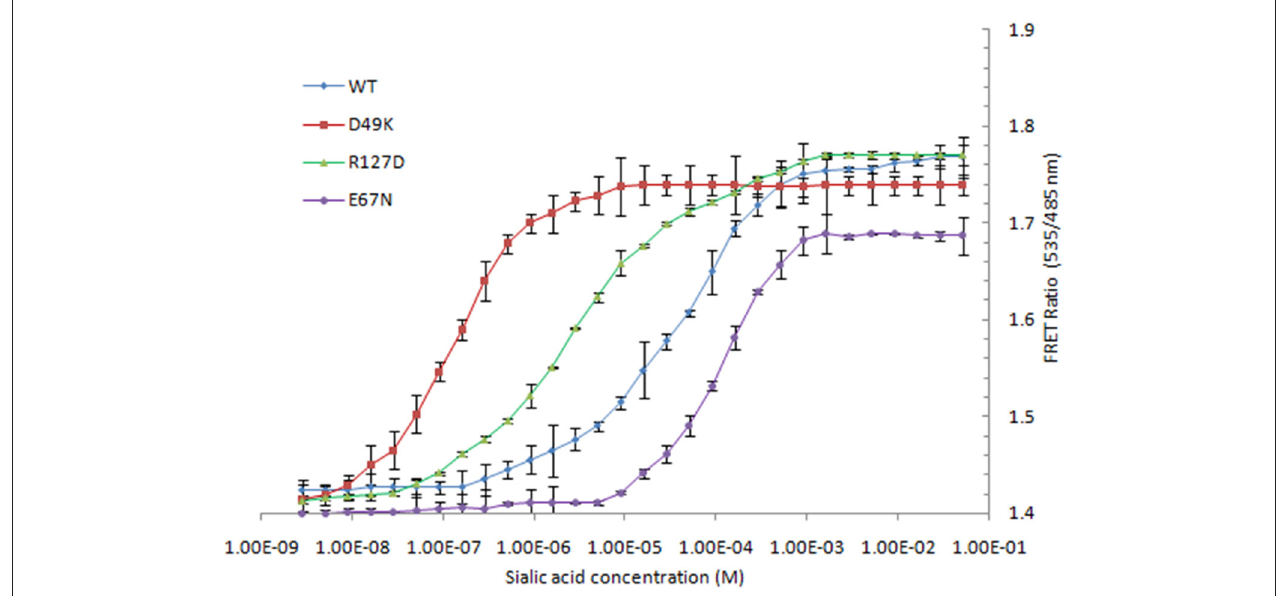
FIGURE 6 | Titration analysis of various affinity mutants (D49K, R127D, and E67N) FLIP-SA. The study was conducted with three replicates independently. Vertical bars show the standard errors. 0.20 mg/ml sensor protein was